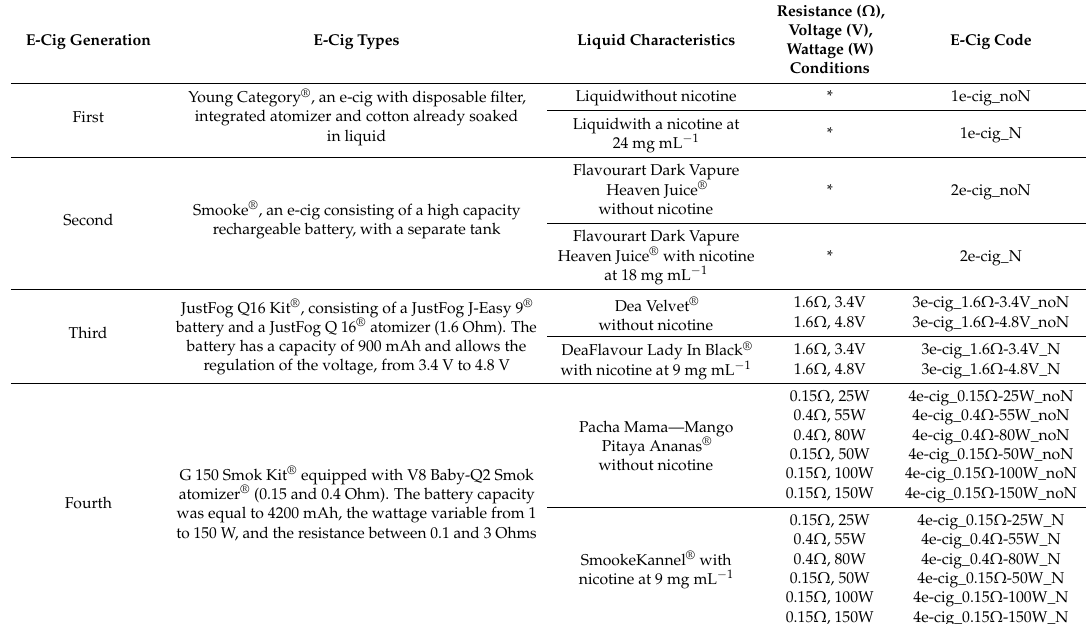
Table 1. E-cigs, e-liquids, operative conditions and relative codes of the experiments. E-Cig